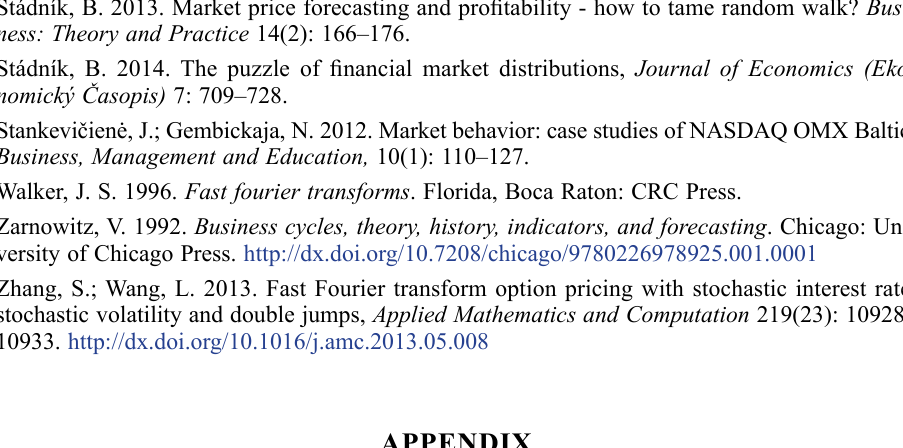
Table 9. List of Tested Stocks, Internet access: http:pozemstan.cz/list.pdf The core Matlab sources, Internet access: